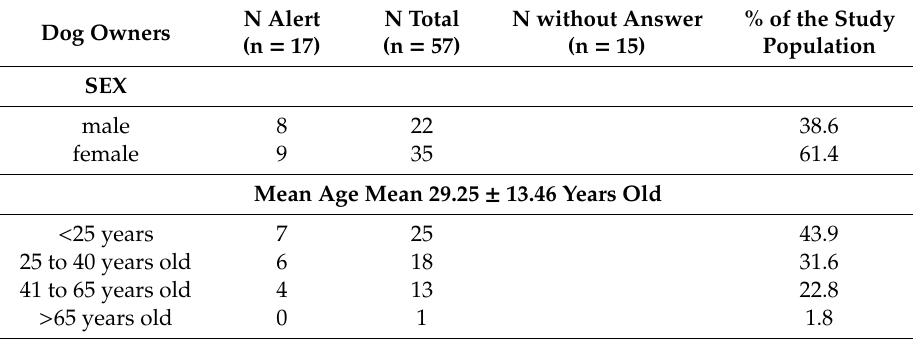
Table 1. Demographics of Dog Owners in our study sample.